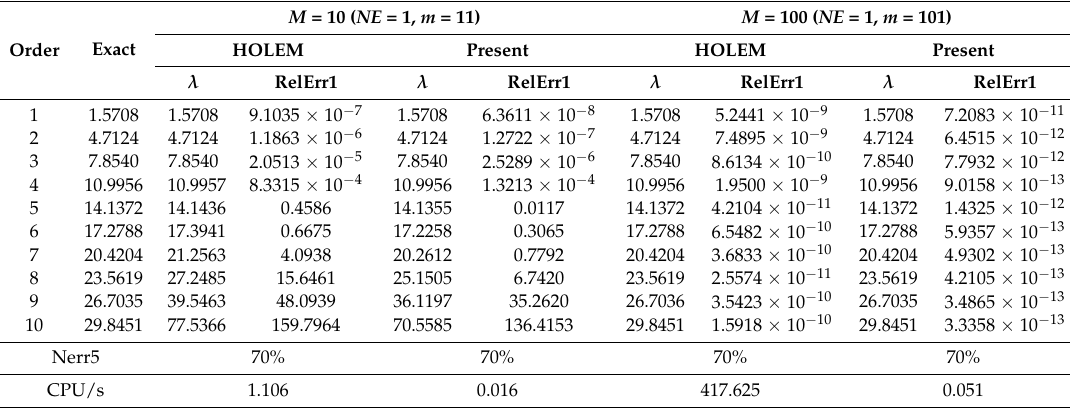
Table 6. Frequency comparisons of rod using high-order rod